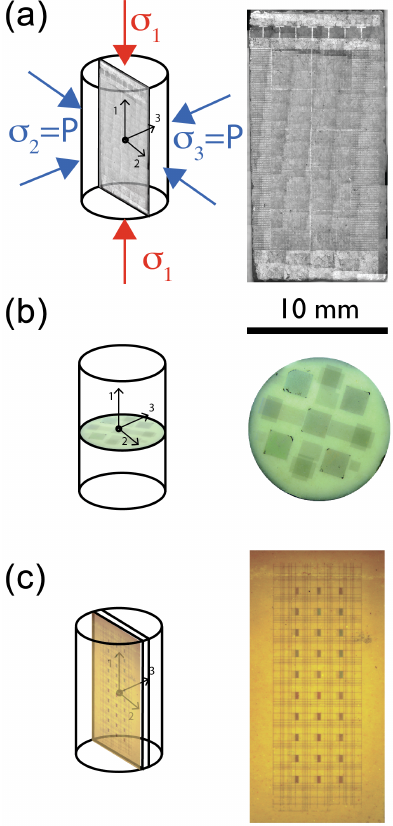
Figure 8. Experimental setup for studying creep in Carrara marble, San Carlos olivine, and fine-grained Solnhofen limestone at high temperatures and P c = 300MPa in a Paterson Instruments gas ap- paratus. (a) The composite half cylinder is composed of two pieces; one is gridded using photolithography, and the other is polished and sputtered with a window-shaped metal layer. Panels (b) and (c) show the composite setups used when the patterning involved e- beam lithography. San Carlos olivine was deformed using the setup in panel (b) : a patterned 1mm thick disk was introduced between two short olivine samples. Solnhofen limestone was deformed us- ing the setup in panel (c) : a patterned 1mm thick rectangular slab was introduced between two half